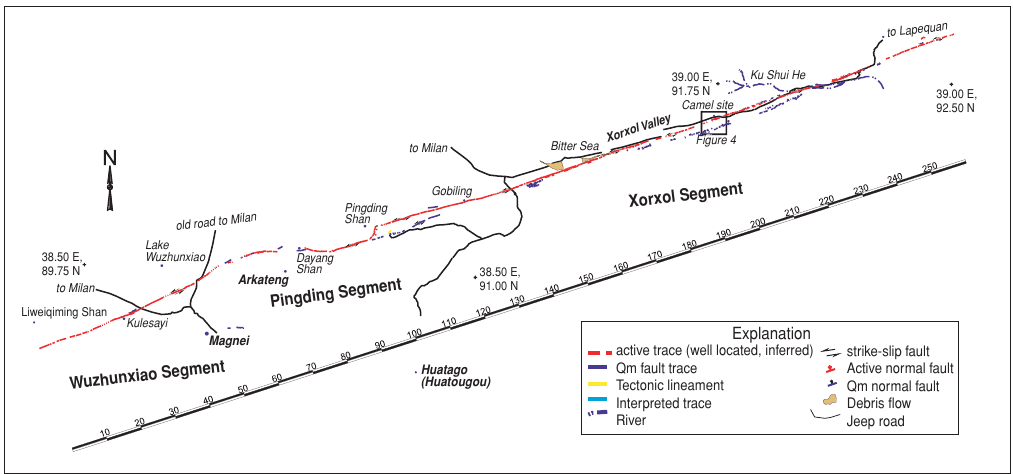
Fig. 3. Fault trace map of Central Altyn Tagh Fault (ATF) showing geometry of most recent and Late Qua- ternary rupture traces. Major roads, location of geographic landmarks, and towns are also shown for reference. This portion of the ATF is predominantly left lateral and has well-developed strike-slip topography ( e.g. , Xorxol rift valley). However, it has not produced instrumentally recorded earthquakes > M 6. The active trace traverses alluvial flats around Lake Wuzhunxiao and the Bitter Sea and bedrock in the Arkateng and Pingding mountain ranges. Two geometric boundaries are identified: the (cid:190) 7 km wide Arkateng Restraining Bend and the 4 km wide Pingding releasing step. These geometric boundaries de fine the westernmost Wuzhunxiao, the Central Pingding, and the easternmost Xorxol segments. The boundaries serve as a framework for interpreting offset data and esti- mating rupture extent because such discontinuities commonly act as rupture